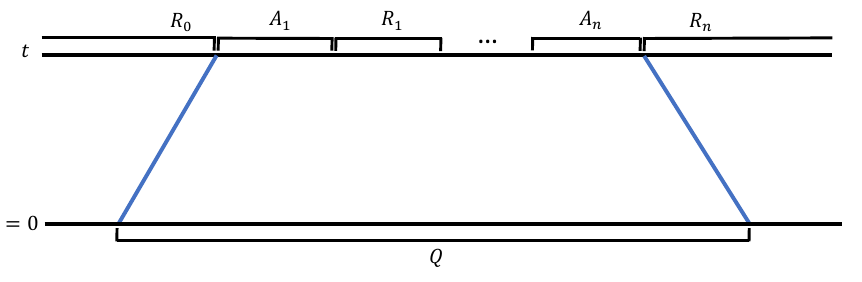
Figure 7 . When initial operators in Q develop a void in A = A 1 · · · A n , this leads to multiple- partite entanglement among regions R 0 , R 1 , · · · R n . Here Q is J ( A 1 R 1 · · · R n − 1 A n )